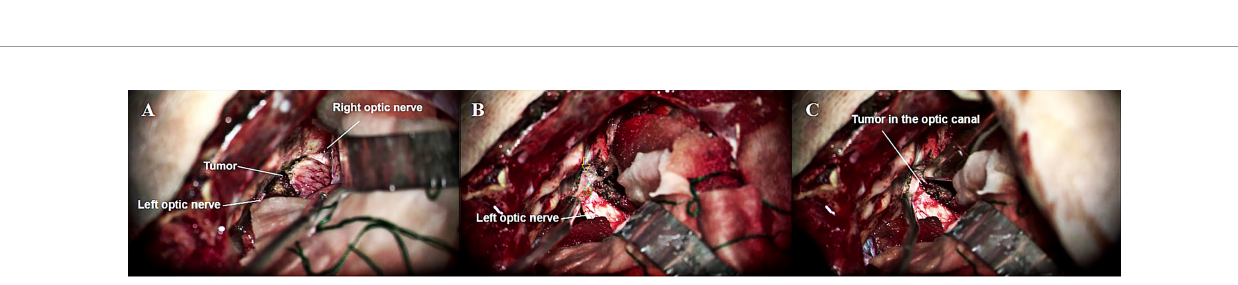
FIGURE 4 | (A) Exposure of bilateral optic nerves and tumors via left subfrontal approach. (B) Open the left optic canal (Yellow arrow) and the left falciform ligament (Green arrow). (C) The left falciform ligament was incised to expose the optic canal